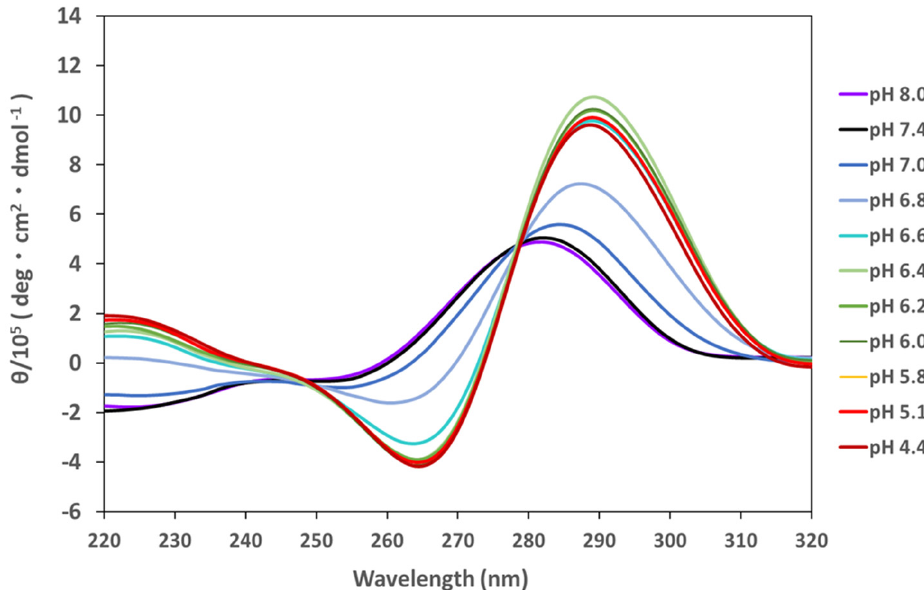
Figure 1. CD spectrum of HRAS2 i-motif in 10 mM Tris-HCl, 10 mM NaCl (pH 8.0, 7.4, 7.0), 10 mM MES, 10 mM NaCl (pH 6.8, 6.6, 6.4, 6.2, 6.0, 5.8), or 10 mM sodium acetate buffer (10 mM CH 3 COOH or CH 3 COONa, pH 5.1, 4.4) at 20 °C.